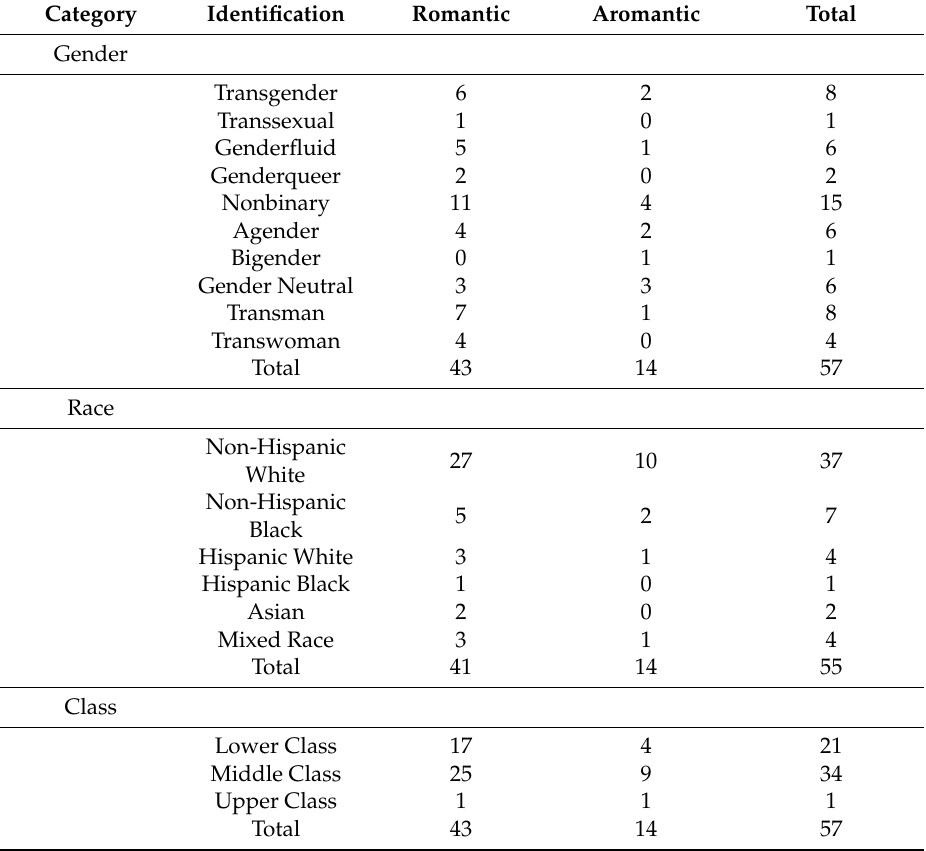
Table 1. Asexual sample